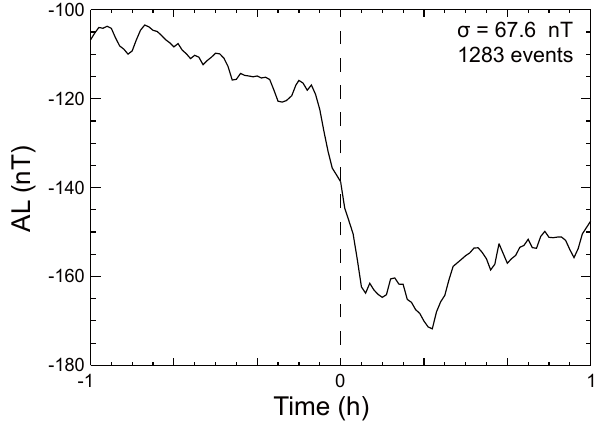
after the time of severe magnetic fluctuation events.